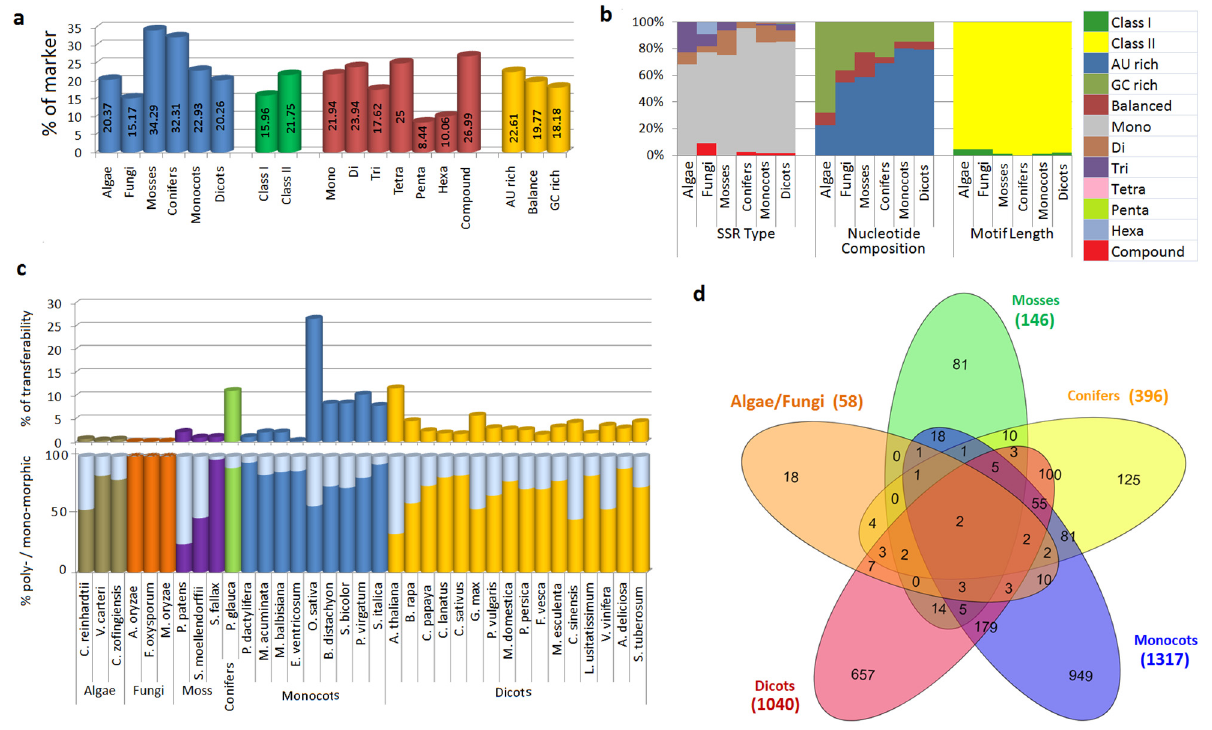
Figure 4. Comparative features of pre-microRNA simple sequence repeat (SSR) primers and in silico characterization, transferability and polymorphism of SSR markers. ( a ) Primer modeling success (%); ( b ) primer modeling success rate partitioned on the basis of SSR type, nucleotide base composition of SSR motif and motif length; ( c ) transferability (%) and polymorphism (%) of SSR markers among 34 species and ( d ) number of transferable SSR markers among six plant taxonomic groups.